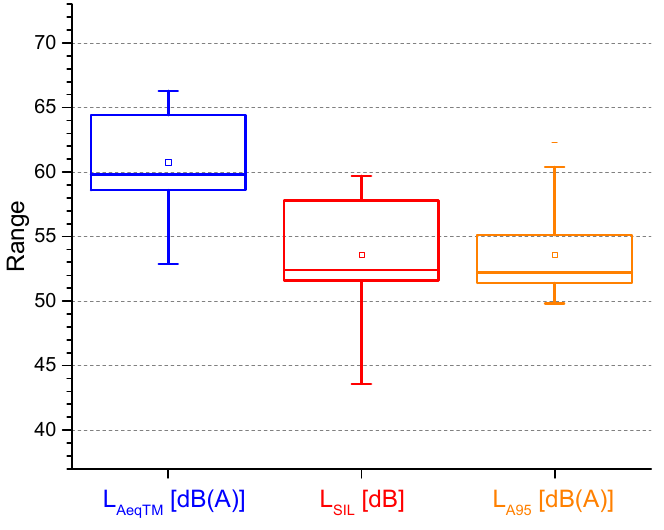
Figure 2. Box plots of the L AeqTM , L SIL , and L A 95 values in the wards surveyed. The range of the mean octave band spectrum observed in the wards is given in Figure 3, showing that the sound energy, as expected, decreases with increasing frequency except in the range of 125–500 Hz. This pattern is also responsible for the high values obtained for the applied room criteria RC Mark II (from 47 to 61) and NCB (from 44 to 60) given in Table 4. The methods detected unbalanced spectra with “hissy” components, as reported by the quality assessment index ( QAI ), as always greater than 5, a value corresponding to a presumed neutral spectrum. The observed range of QAI (from 10 to 31) is due to the spectrum unbalance at mid-frequencies.